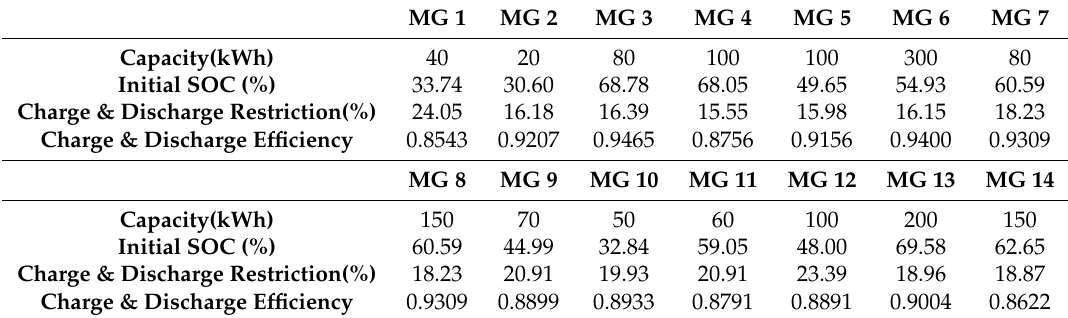
Table A1. Battery energy storage system properties of 14 microgrids in the Guizhou Grid.